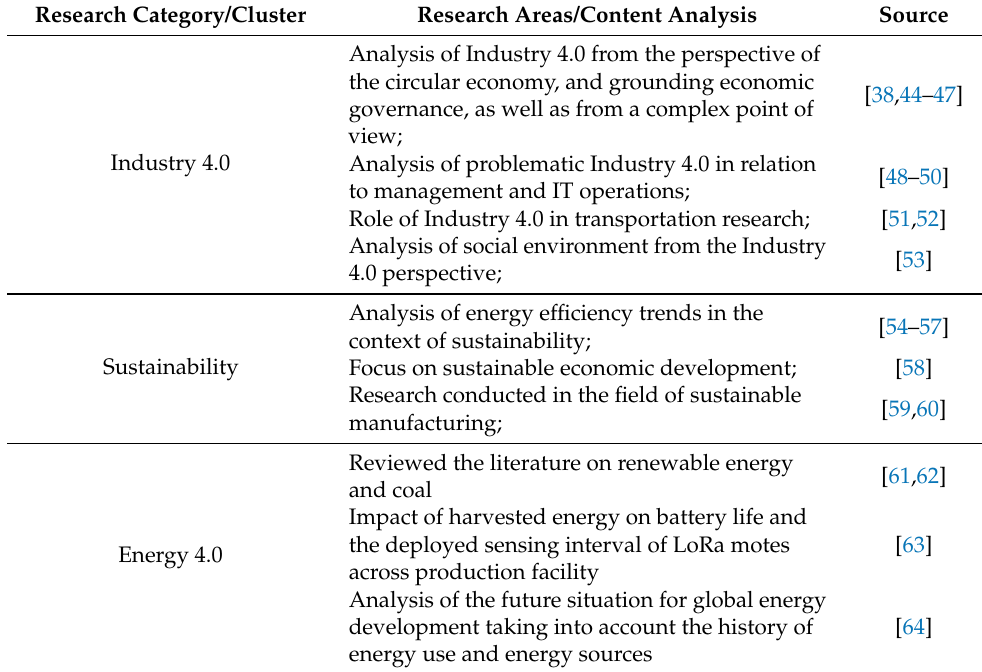
Table 1. Industry 4.0, Sustainability, Energy 4.0–clusters summary of the selected